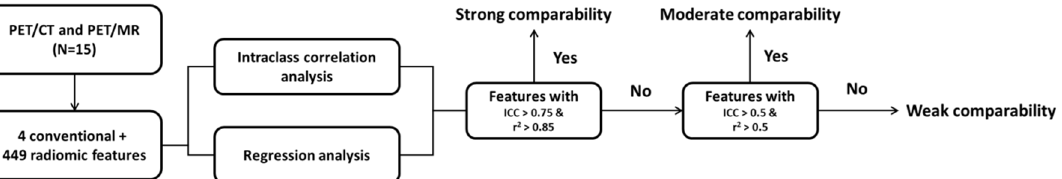
Figure 2. Flowchart of data analysis.